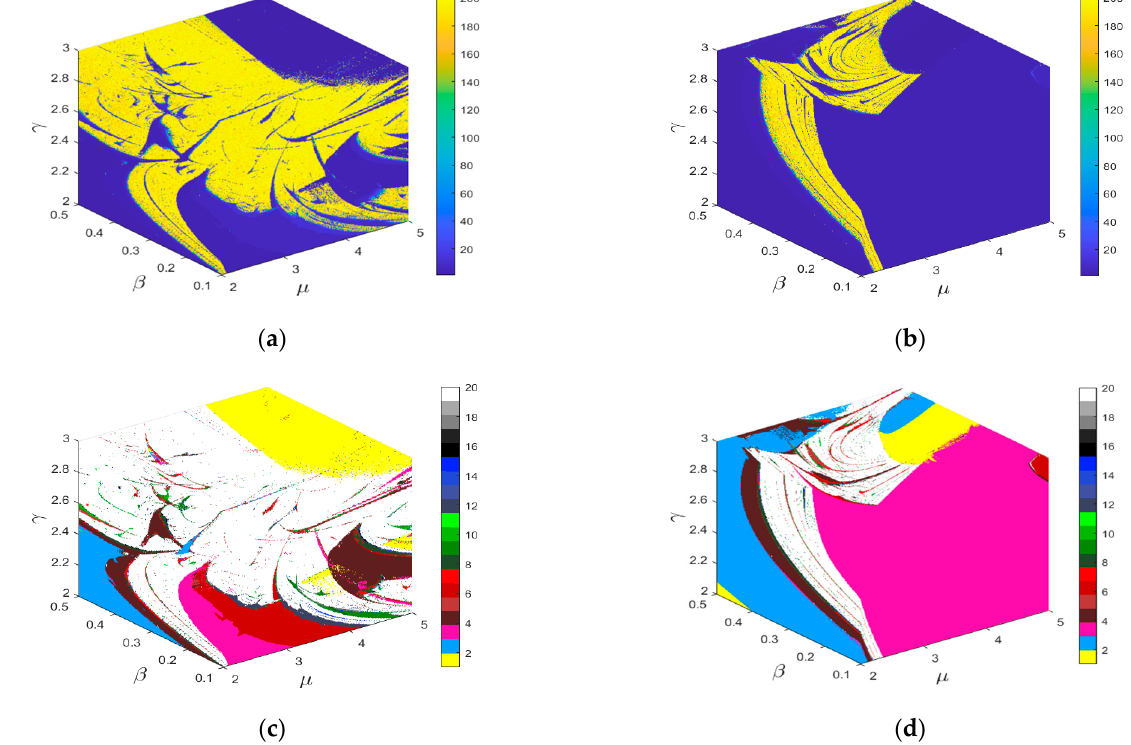
Figure 6. Three-parameter bifurcation diagram: ( a ) model 1; ( b ) model 2; ( c ) model 1; ( d ) model 2.